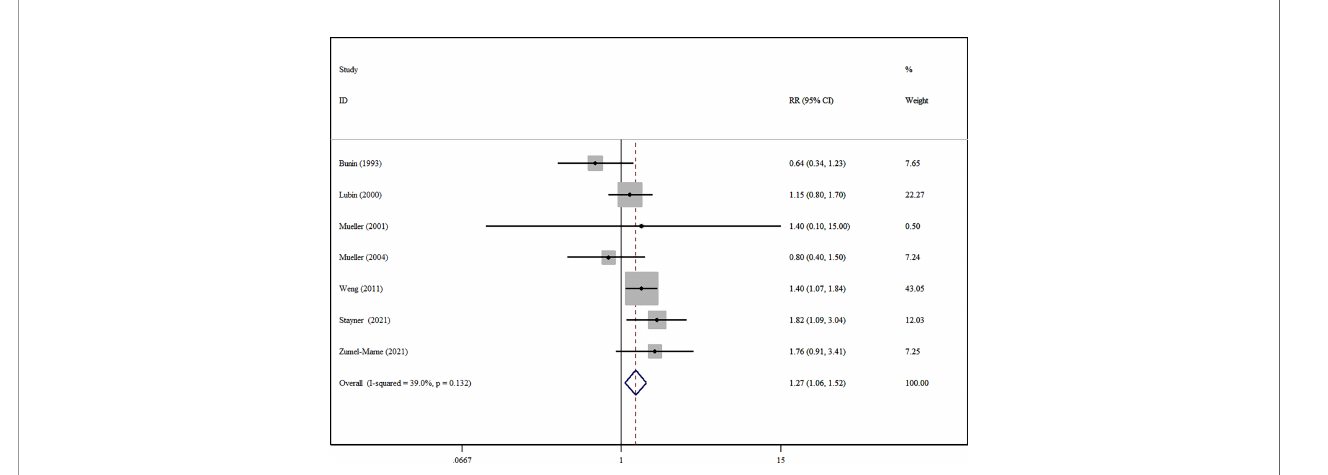
FIGURE 3 | A forest plot showing risk estimates of the association between nitrate and brain tumors in